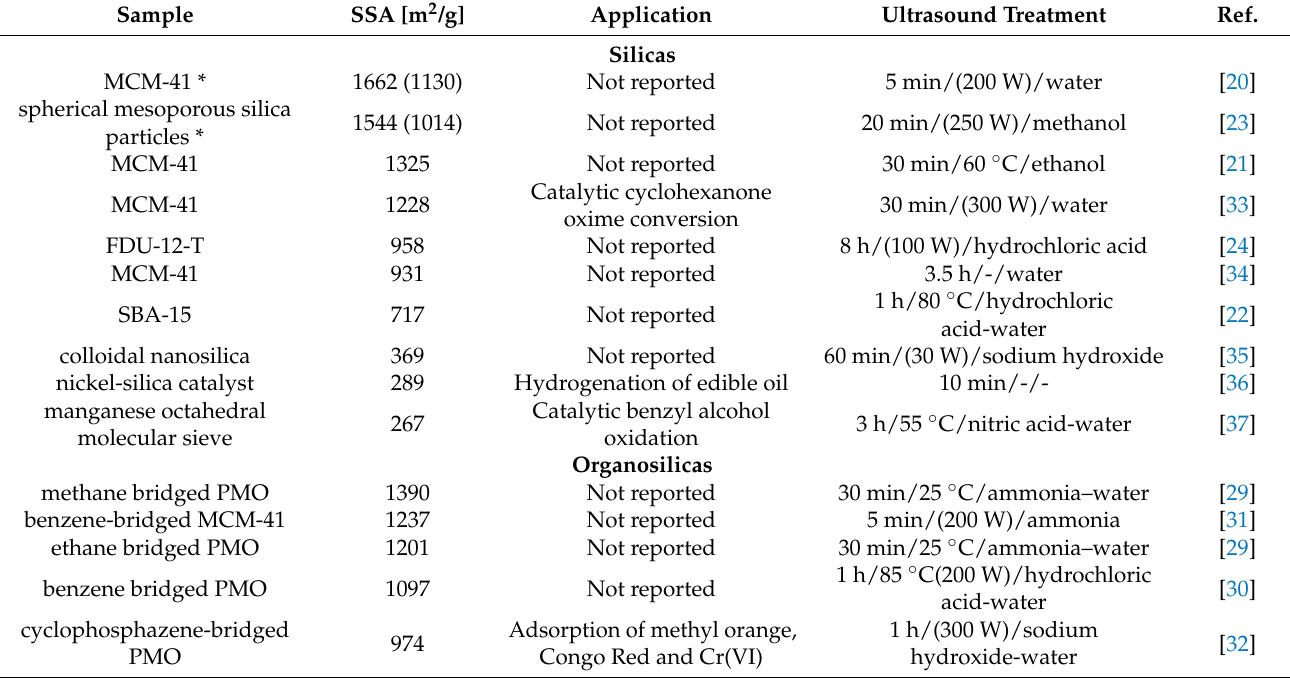
Table 1. Porous silicas and organosilicas obtained via sonochemical-assisted